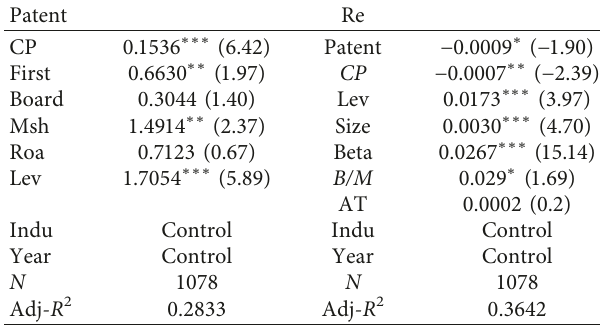
Table 6: Multivariate regression test (mediating